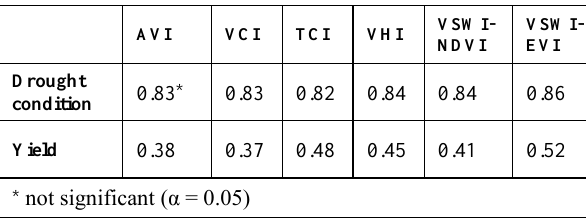
Table 3. Correlation of remote sensing drought indices with annual average of soil moisture and total grain yield